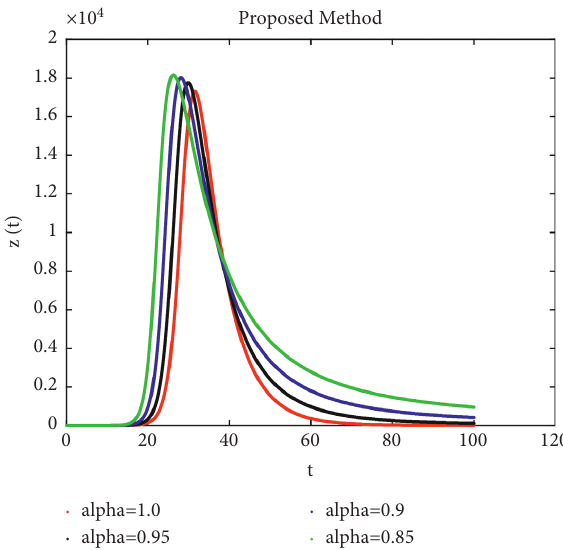
Figure 16: Dynamical behavior of free HIV virus particles at τ � 1 and various fractional order under Mittag-Leffler